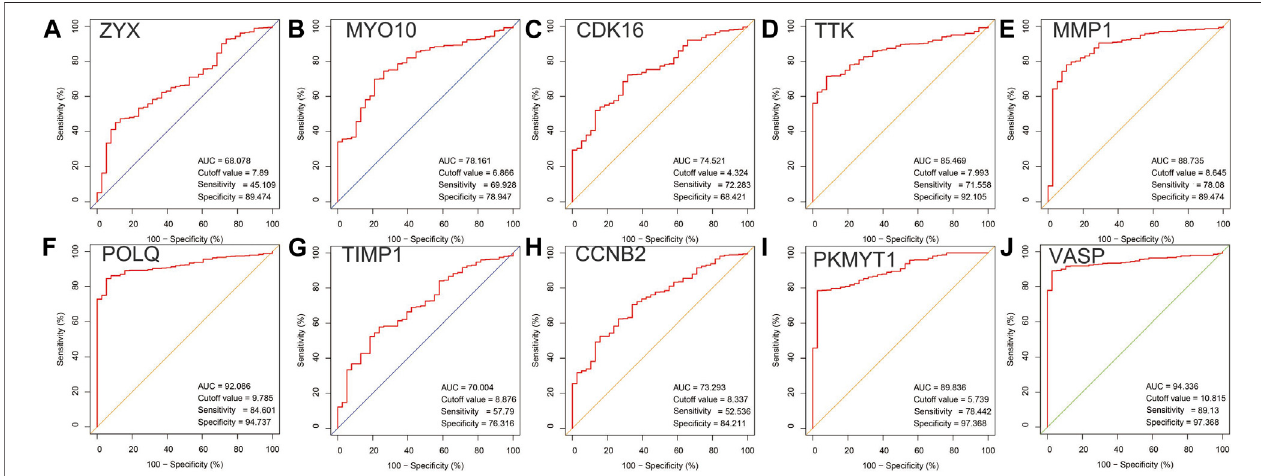
FIGURE 8 | (A – J) Receiver operating characteristic curves of 10 hub genes in PPI